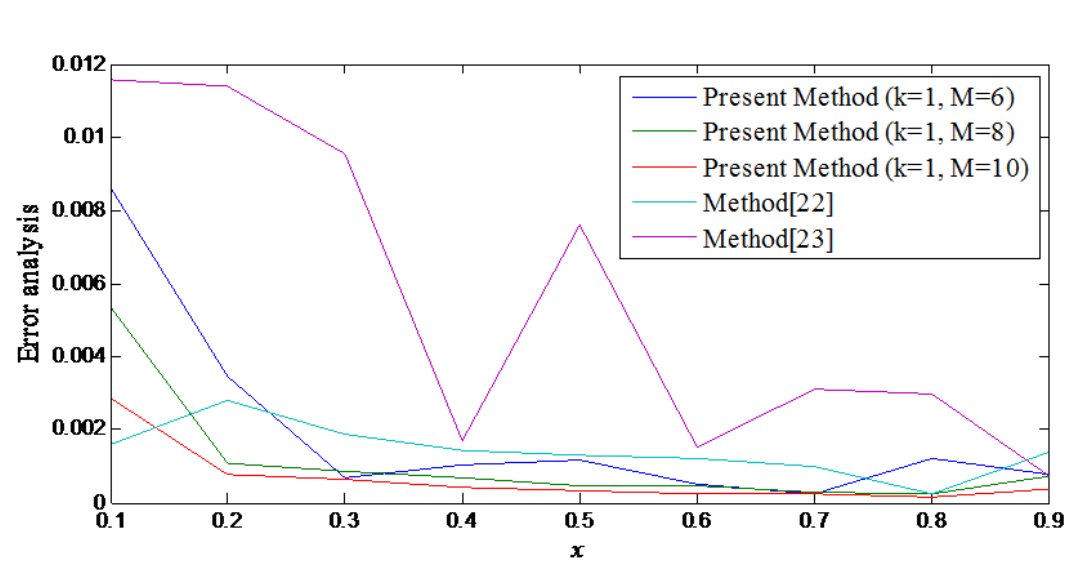
Fig. 6 Comparison of Error analysis of example